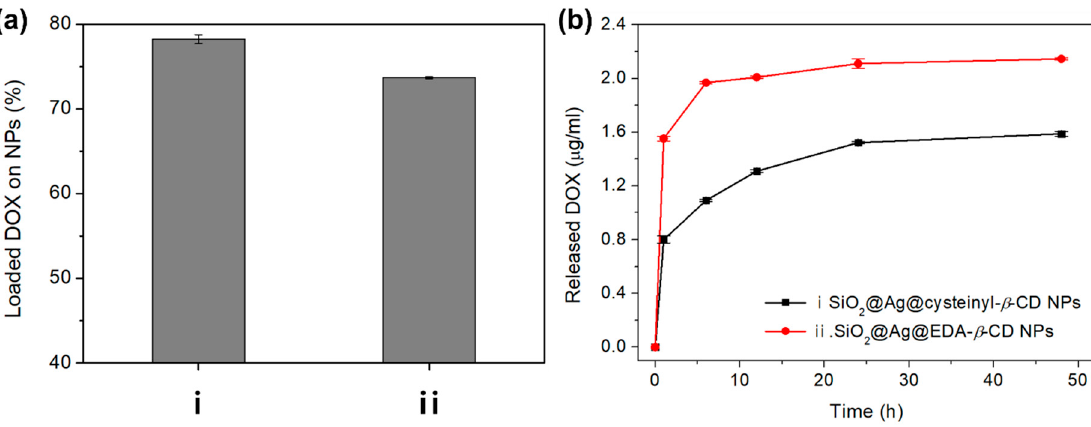
Figure 5. ( a ) The percentage of DOX loaded onto each NP; i) SiO 2 @Ag@cysteinyl ‐ β ‐ CD NPs and ii)